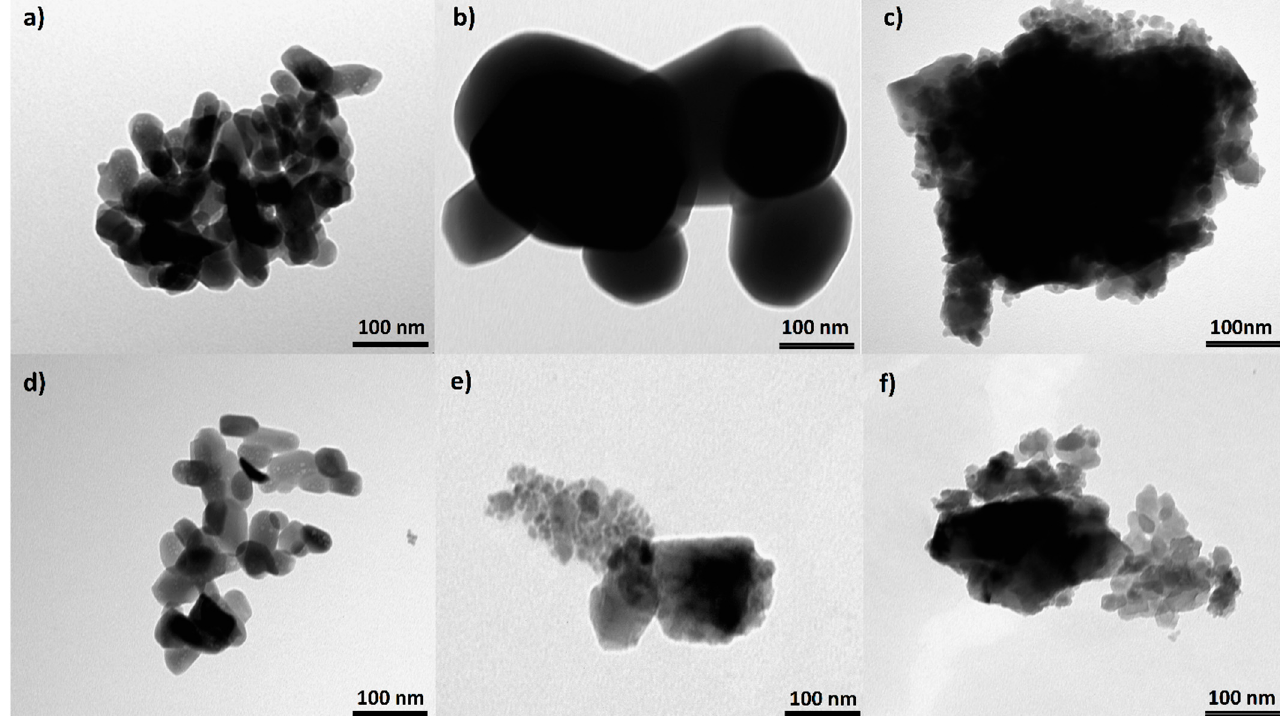
Figure 2. TEM pictures of ( a ) HAP-800, ( b ) HAP-1000, ( c ) HAP-1200, ( d ) FAP-800, ( e ) FAP-1000, and ( f ) FAP-1200.